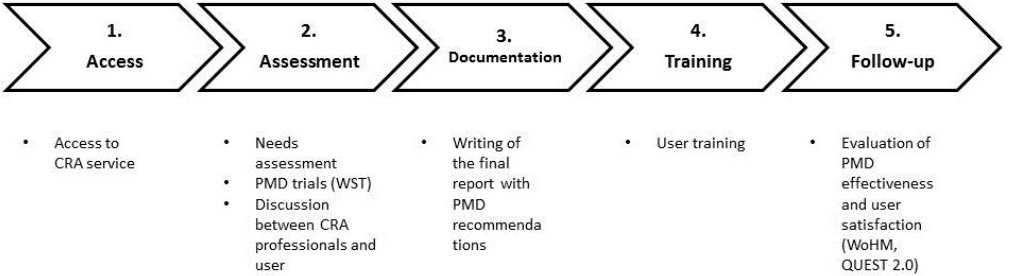
Figure 4. The CRA-PMD assessment and training program.